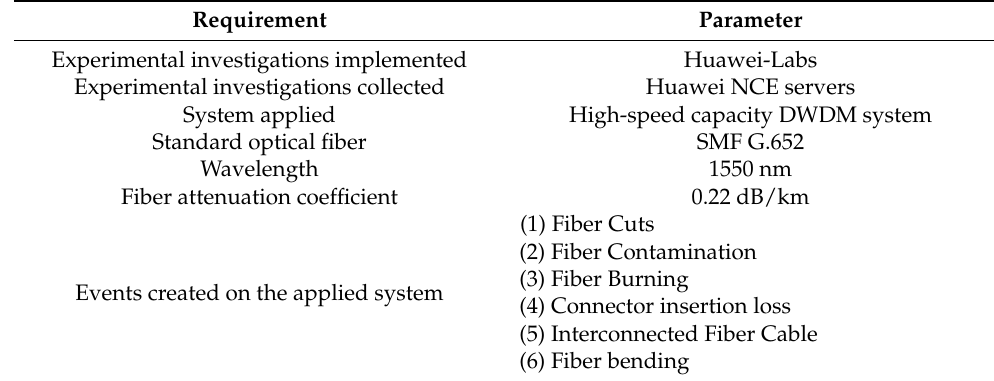
Table 4. The requirements for the implemented system were to monitor and analyze the fiber line and collect results.